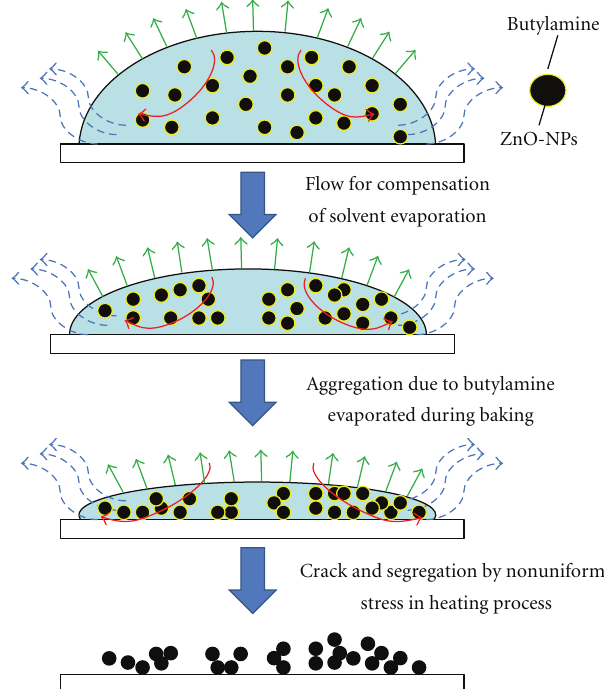
Figure 5: The modified formation process of droplet drying onto the surface of the substrate with inkjet printing